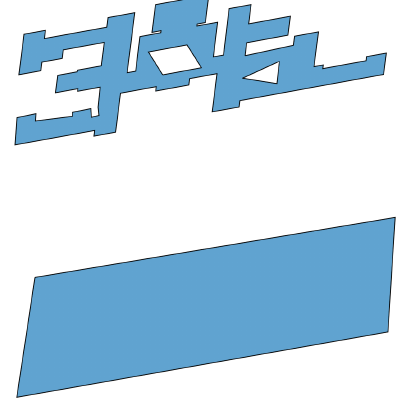
Figure 1: Two LODs of a building footprint. Note that there are no vertices, edges or faces with the same geometry in both LODs, and that many primitives in the higher LOD are equivalent to a single one in the lower